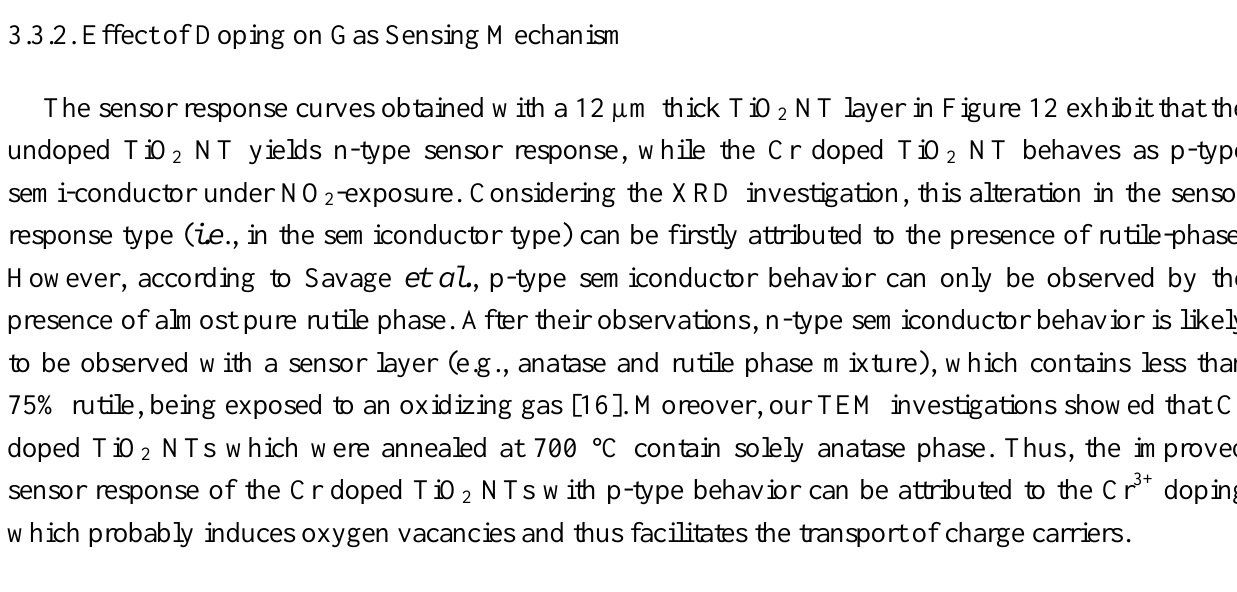
Figure 12. Responses of the undoped and Cr doped TiO 12 µm and annealed at 700 °C towards various NO